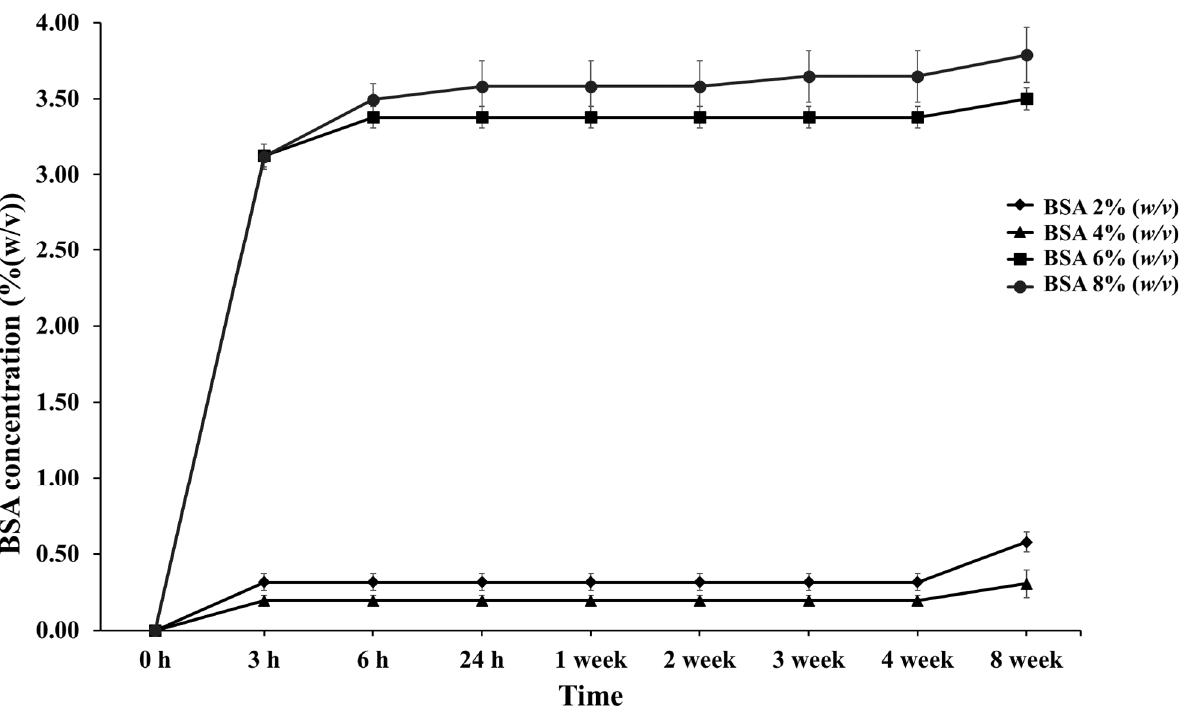
Figure 3. Percentage of cumulative release profiles of PLG microparticles with various concentrations of BSA encapsulation at designated time intervals throughout the 8-week period.